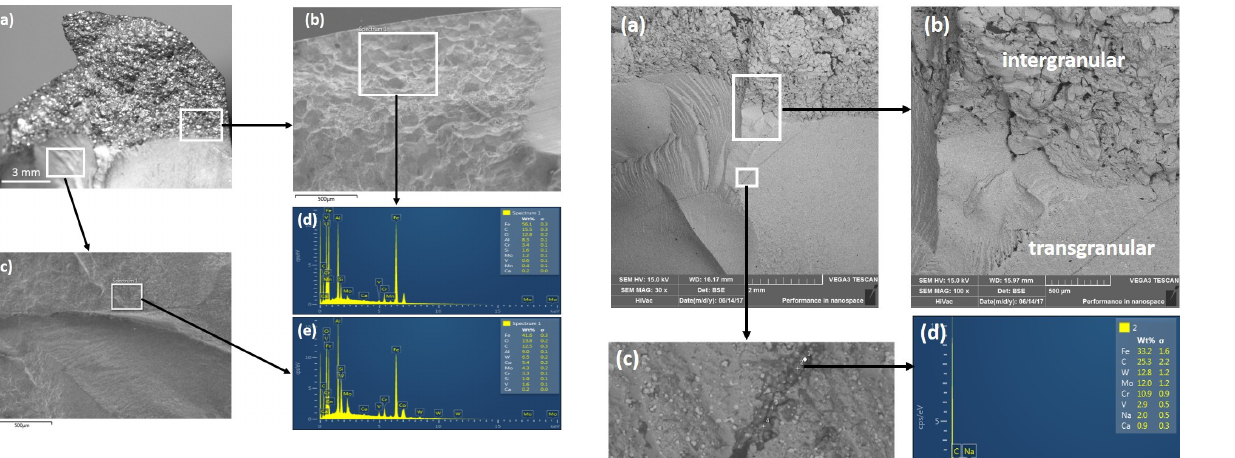
Figure 3: The difference of the chemical composition between the fine and the rough surface (a) macro view, (b) rough surface, (c) fine surface, (d) EDS of rough surface, (e) EDS of fine surface